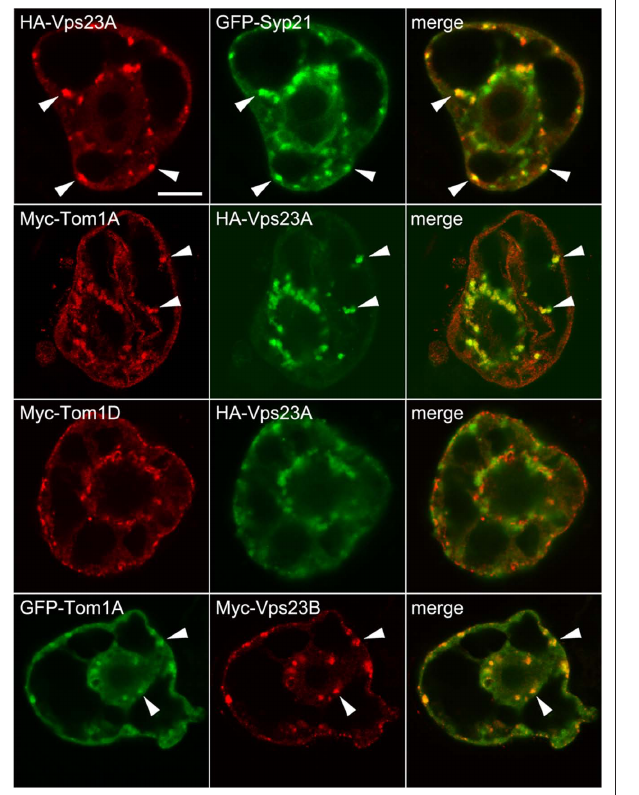
FIGuRE 3 | Subellular localization of Vps23A and co-expression of Tom1A and/or Tom1D with Vps23A or Vps23B. BY‑2 cells were co‑transformed with the indicated gene constructs and then cells were processed, imaged and analyzed by CLSM as described in the legend of Figure 2 . The yellow color in the merged images indicates co‑localization between co‑expressed proteins; white arrowheads also indicate obvious protein co‑localization. Bar =